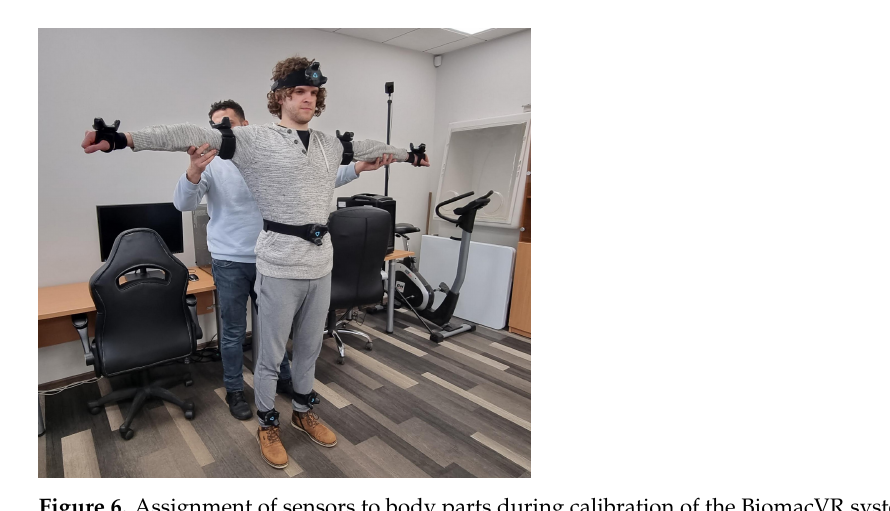
Figure 6. Assignment of sensors to body parts during calibration of the BiomacVR system. A person is assisted by a nurse.